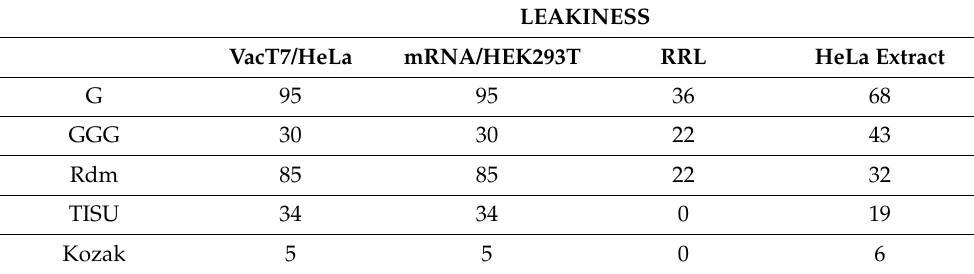
Table 1. Leakiness of the first AUG initiation codon as measured by the relative ratios of the AUG ELK and iAUG a/b/c bands on the immunoblots quantitated using ImageLab (i.e., the percentage of proteins originating from the downstream AUG codons: the higher the score, the more “leaky” is the first AUG). LEAKINESS VacT7/HeLa mRNA/HEK293T RRL HeLa Extract G 95